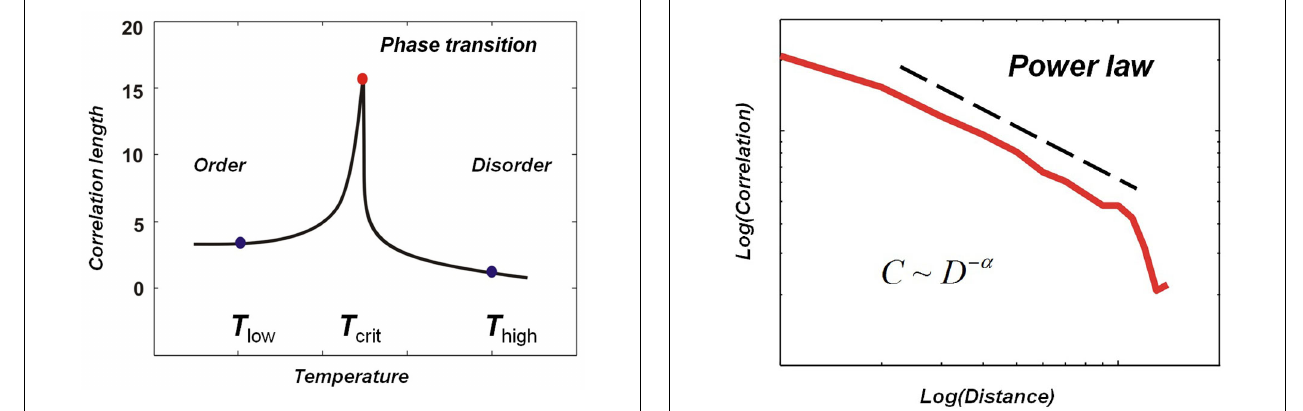
FIGURE 5 | Hypothetical relationship between the average dynamic correlation between two lattice sites and the distance between those lattice sites at the critical temperature in a small simulation of the Ising